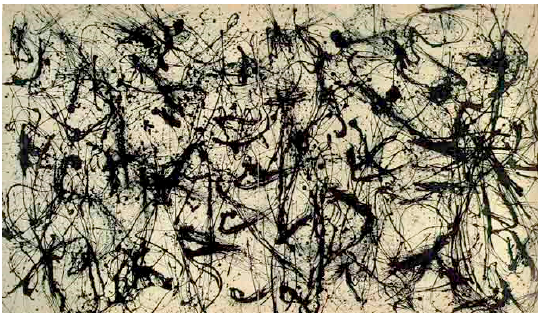
Figure 2. Jackson Pollock, Lavender Mist: Number 1 , 1950 , 1950, oil, enamel, and aluminum paint on canvas, 87 × 118 in. (221 × 299.7 cm). National Gallery of Art, Washington, D.C. Ailsa Mellon Bruce Fund. © 2022 The Pollock-Krasner Foundation/Artists Rights Society (ARS), New York .